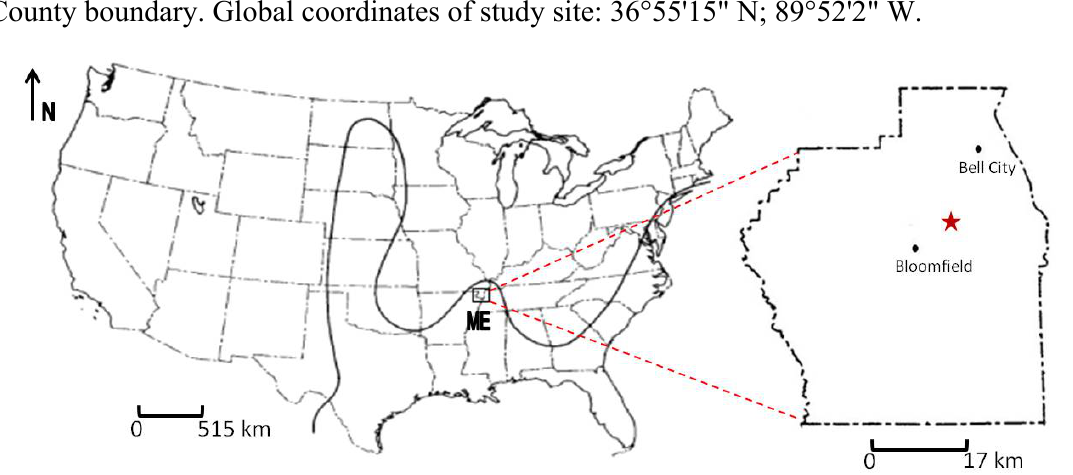
Figure 1. Late Cretaceous shoreline for eastern and central regions of the United States from [8]. ME: Mississippi Embayment. Inset: location of the study site (star) in Stoddard County, Missouri near the towns of Bloomfield and Bell City. Dashed line: